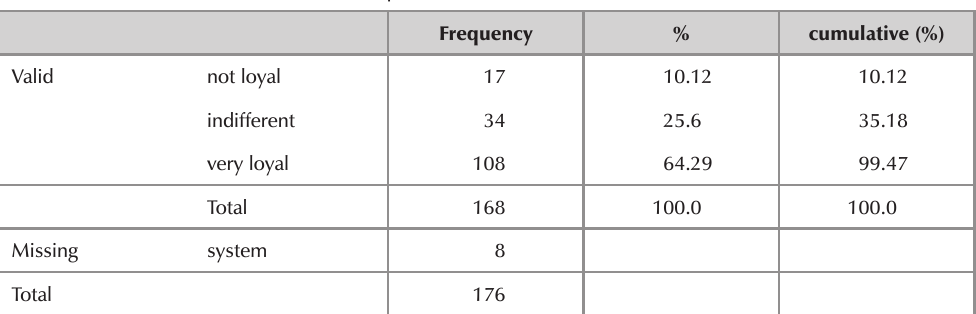
Table 1 indicates that 64.29 per cent of the respondents are loyal to their stores, and only 10.12 per cent are not loyal. Store location will be discussed